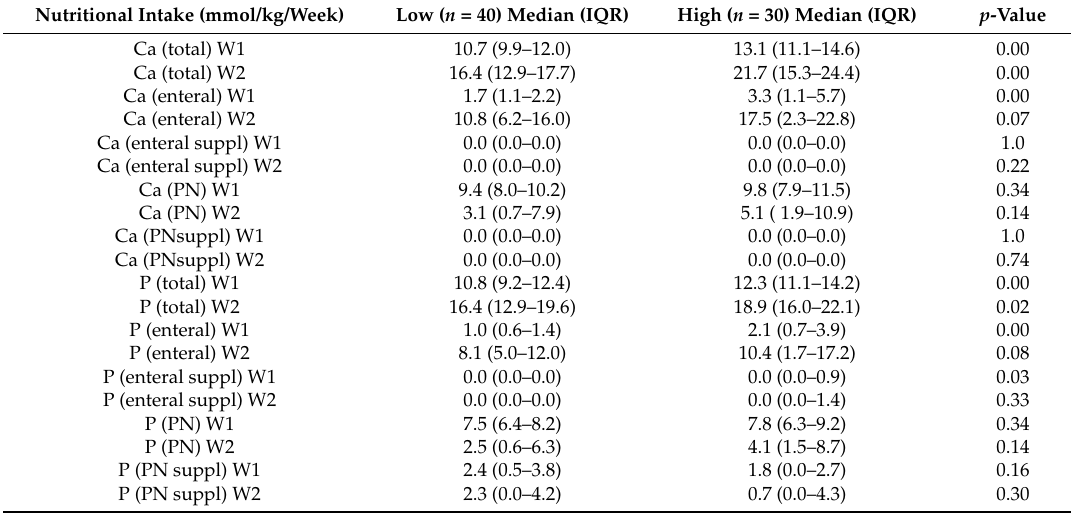
Table A3. Nutritional intake of calcium and phosphorus by route of